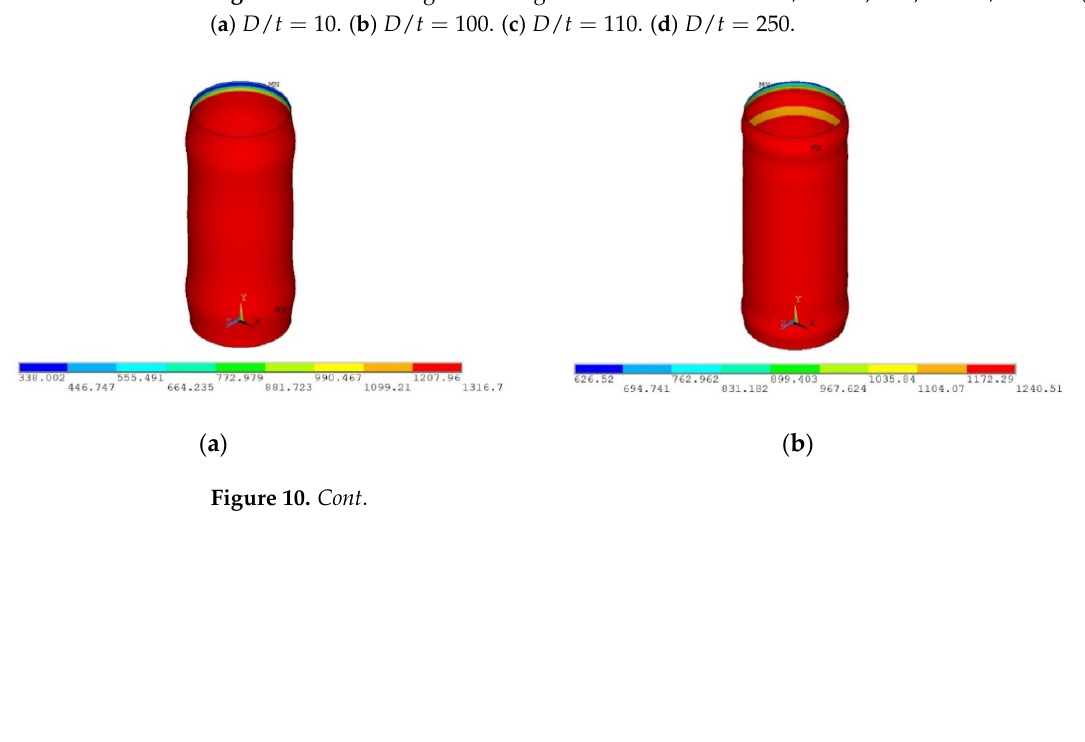
Figure 9. Stress through tube length and failure mode of D / t = 10, 100, and D / t = 250 (LC1, S460). ( a ) D / t = 10. ( b ) D / t = 100. ( c ) D / t = 110. ( d ) D / t = 250.